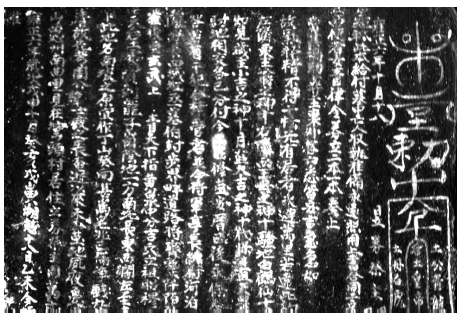
Figure 3. The image with the maximum amount of information after LLE ATGP was used for endmember extraction. After extracting the endmembers of each color region, the abundance map of handwriting endmember was obtained by FCLS (Song et al., 2021; Khajehrayeni and Ghassemian, 2021), shown in Figure 4.